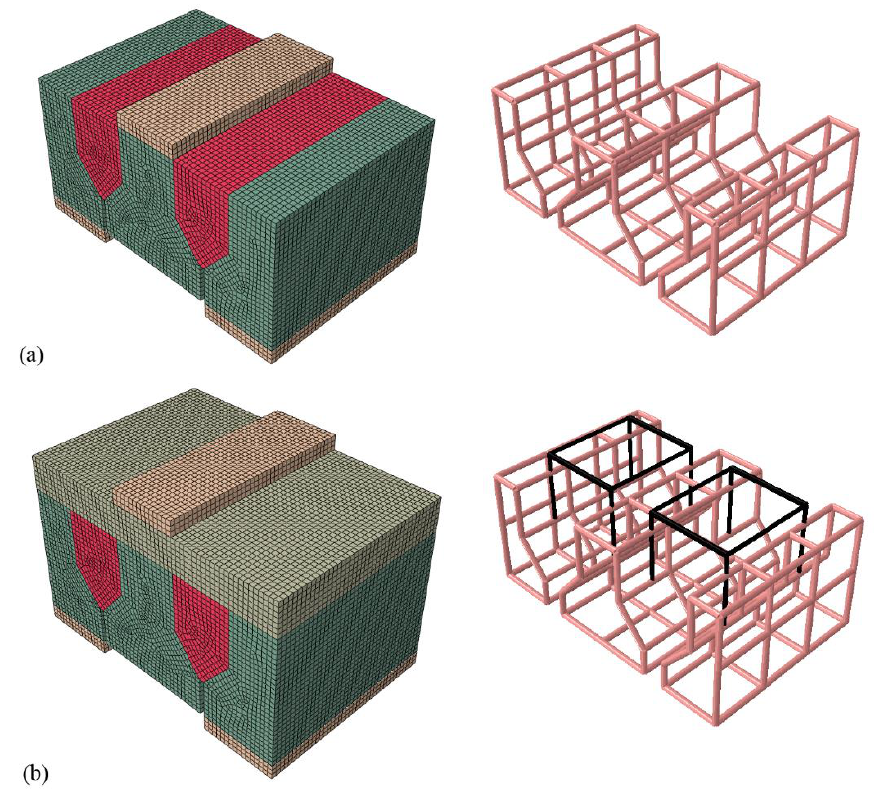
Figure 15. FEMs: ( a ) the SDS test for Type I specimen; ( b ) the SDS test for Type III specimen.